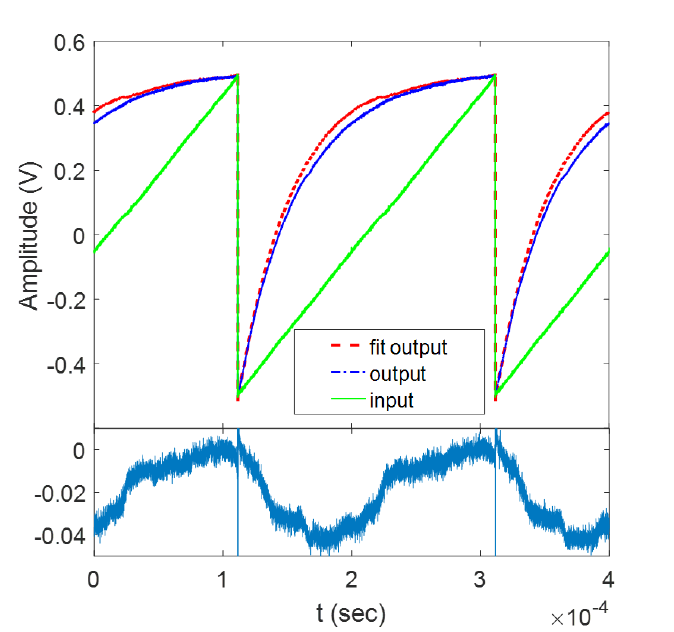
Figure 7. Transformer response to a 5 kHz sawtooth signal. The continuous, green line is the input signal, and the red dash-dot and blue lines are the fit and the data, respectively. The agreement between data and the model is at the level of 4%, as can be appreciated from the lower plot, which is the difference between the output measured and fitted signals. Signals are normalized in